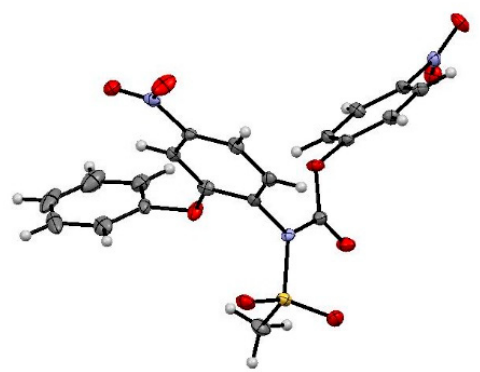
Figure 2. Schematic view of 1 (C—gray, N—blue, O—red, S—yellow). The crucial bond lengths and angles are S-C 1 = 1.75; S-N = 1.69; N 1 -C 2 = 1.45; N 1 -C 14 = 1.38 Å, C 2 -N-S = 118.3(2) ° , respectively (atom numbering according to scheme 3 and deposited cif in CCDC). All bond lengths and torsion angles are collected in Table A1 (Appendix A).